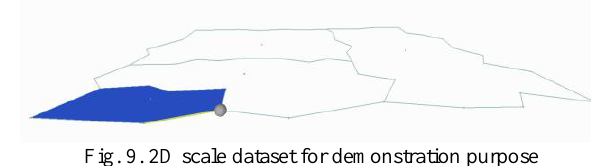
Fig. 9. 2D scale dataset for demonstration purpose